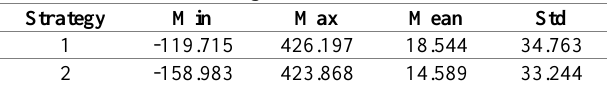
Figure 6 Different of gridded surface gravity anomaly between Strategy 1 and Strategy 2 (Unit: mGal) Table 2 Statistical analysis about the free air anomaly from two strategies (Unit: